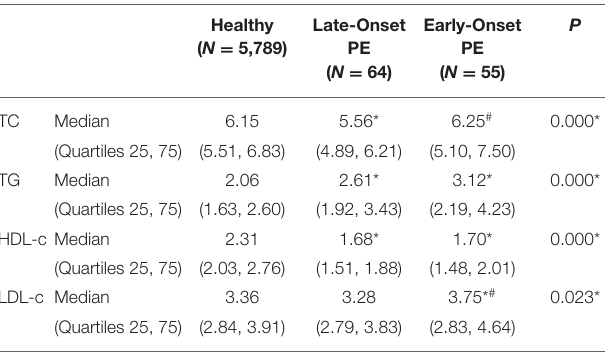
cholesterol; PE, pre-eclampsia.